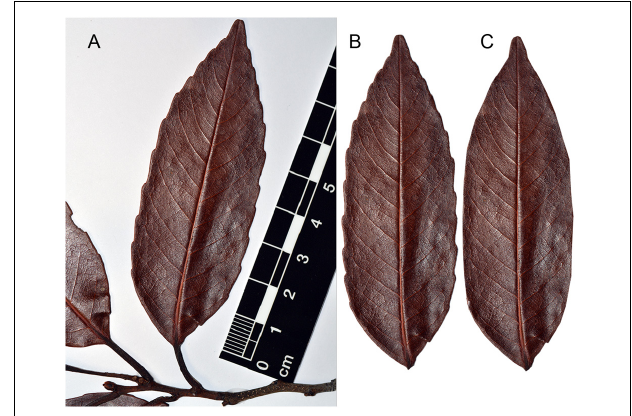
FIGURE 1 | Preparation of the digital leaf samples. (A) Original image of N. discoidea ( Brassospora ) with scale. (B) Leaf sample with petiole removed. (C) Leaf with teeth